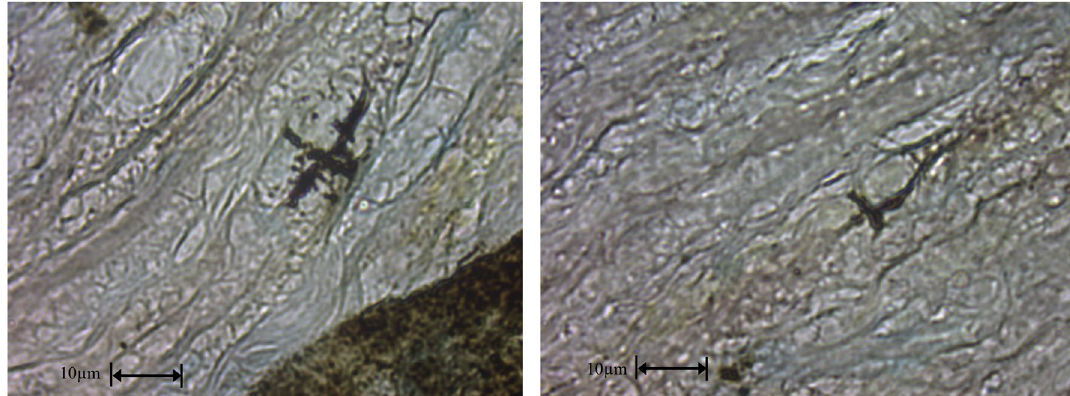
Figure 4. Two different examples (left and right) of Ag deposition (black) in the paranode after electrical stimulation of the rat sciatic